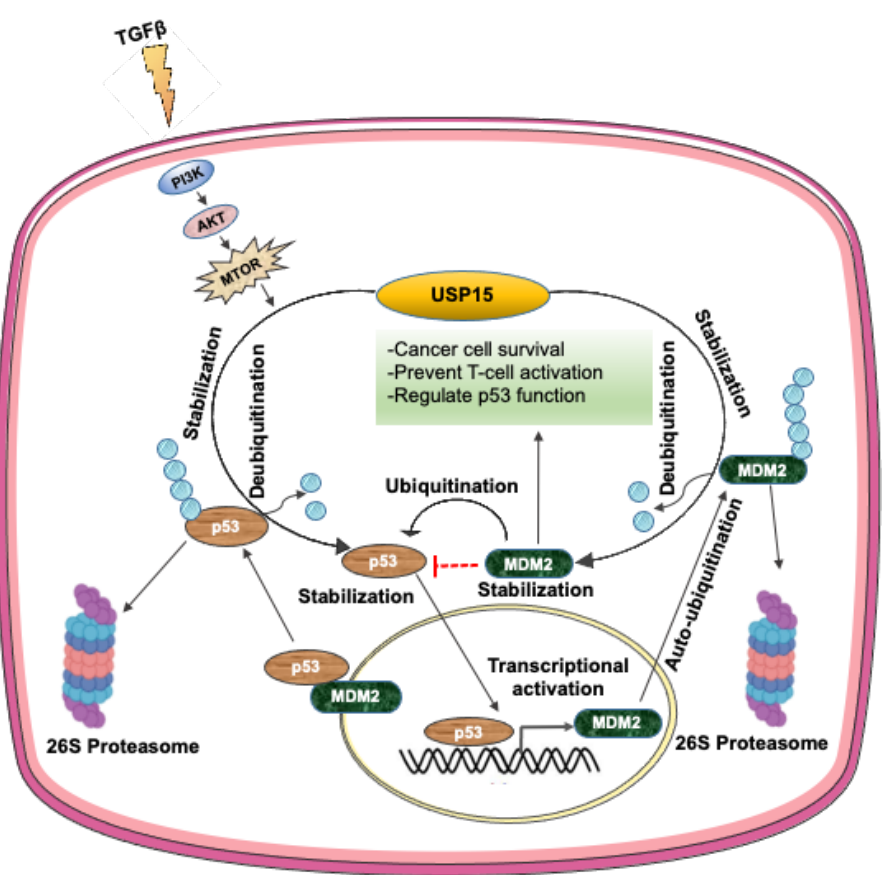
Figure 3. Regulation of p53 signaling by USP15. USP15 translation is upregulated by TGF-β through the PI3K/AKT pathway, which in turn increases the stabilization of p53 by its deubiquitination and activates p53 signaling. In another way, USP15 also promotes the ubiquitin-dependent degradation of p53 by deubiquitination and enhanced stabilization of the E3 ubiquitin ligase for p53, MDM2, resulting in the downregulation of p53 target gene expression [34,84].